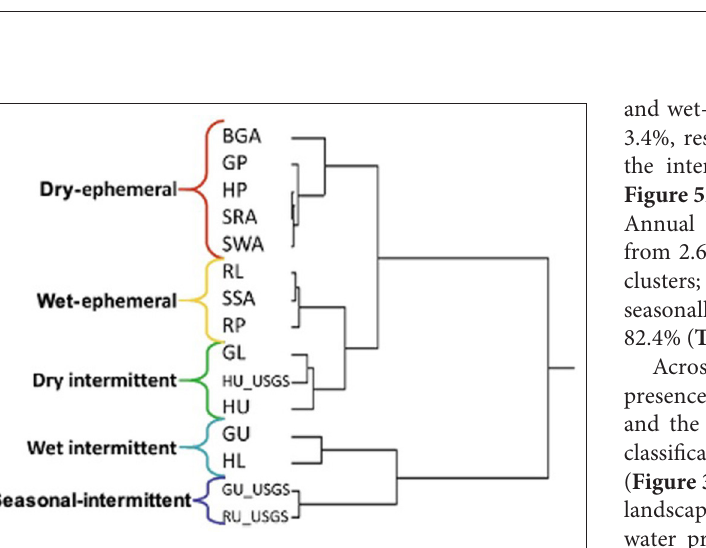
FIGURE 3 | Regressions of percent annual streamflow presence and percent annual water presence vs. mean annual precipitation (MAP, A,B ) for the observation period and stream channel density (C,D) . All regressions were signficicant ( p < 0.05).